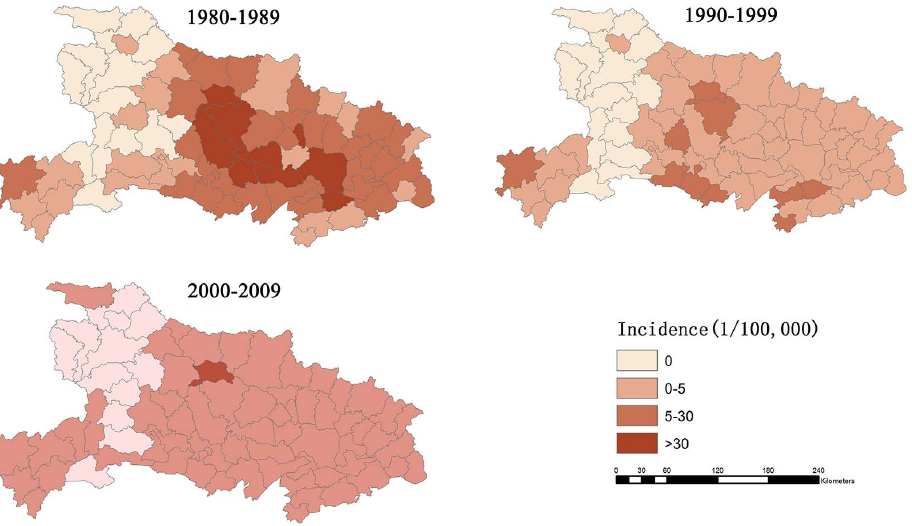
Figure 3. The spatial distribution of HFRS incidence in Hubei Province, China. The color gradient presents the annual incidence of HFRS in thematic maps. All counties were grouped into four categories: non-endemic area, low endemic area with annualized average incidence between 0 and 5 per 100,000, moderate endemic area with annualized average incidence between 5 and 30 per 100,000, and high endemic area with annualized average incidence over 30 per